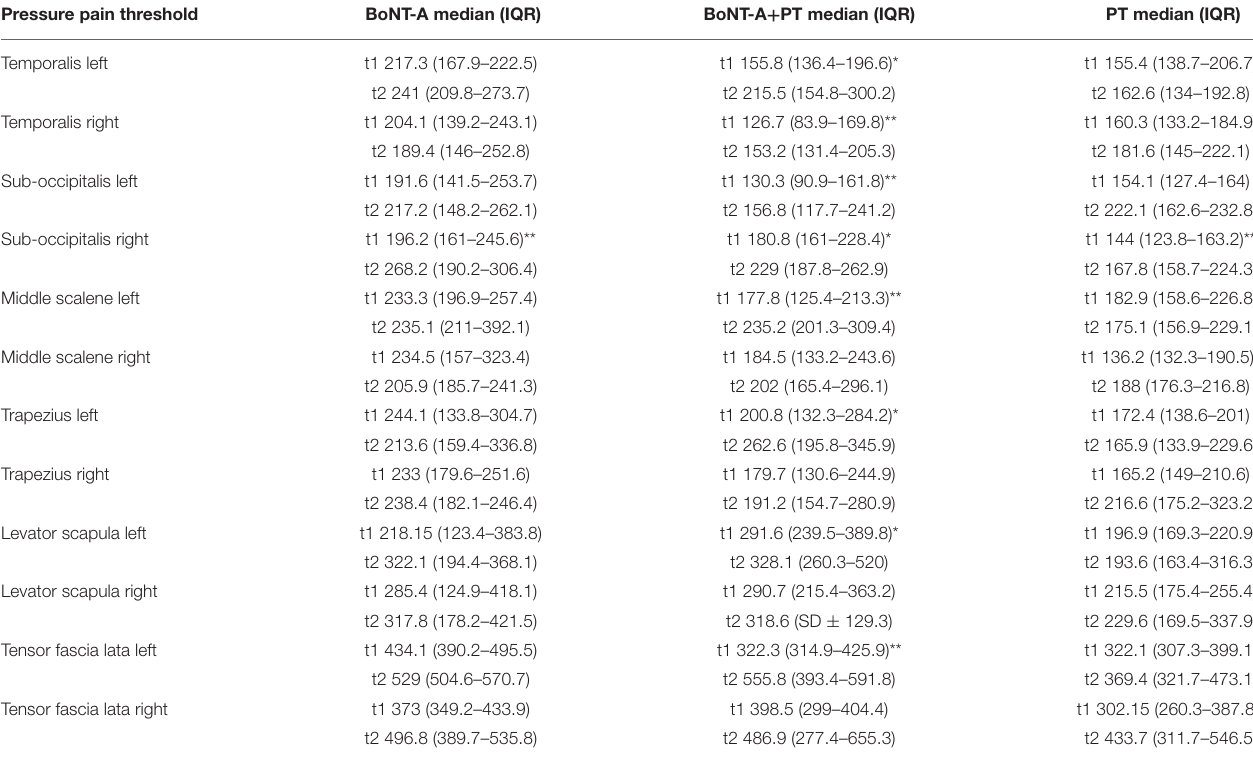
TABLE 1 | Pressure pain threshold in onabotulinumtoxin-A (BoNT-A) group, in onabotulinumtoxin-A plus physical therapy group (BoNT-A + PT), and physical therapy group, before and after each treatment (at T1 and T2). Pressure pain